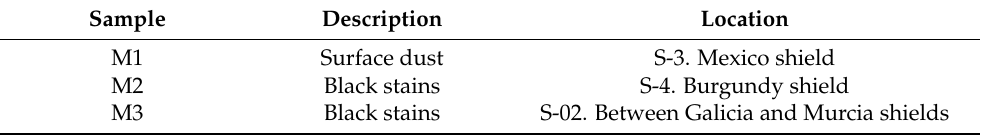
Table 1. Description and location of the samples